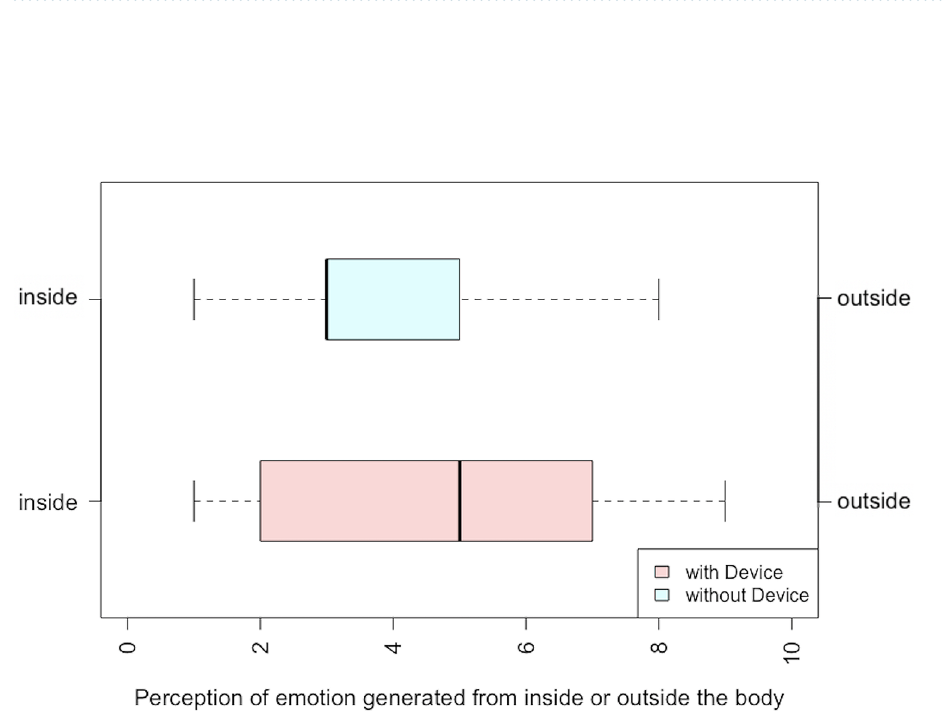
Figure 4. Perception of emotion generation (inside the body or outside the body) reported by the